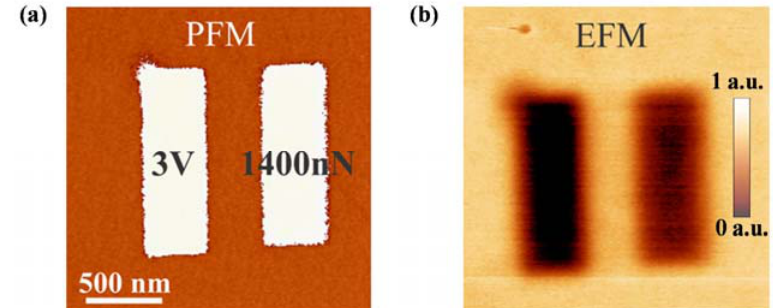
Figure 28. ( a ) PFM phase images of the 4.8-nm-thick BaTiO 3 film after the generation of the downward-oriented domains by electrical poling (left) and mechanical loading force (right); ( b ) EFM image taken at the same location as the PFM images, which is acquired with a dc read voltage of +2 V; ( c ) tunneling current map acquired in the c-AFM mode with a dc read bias 0.3 V at the same location as the PFM and EFM images, where the bright contrast corresponds to a higher conductivity; ( d ) local I − V curves measured for the as-grown film area with upward polarization (green), electrically downward-switched domain (red), and mechanically downward-switched domain (blue), which reveals that mechanically induced TER is larger than the electrically induced TER